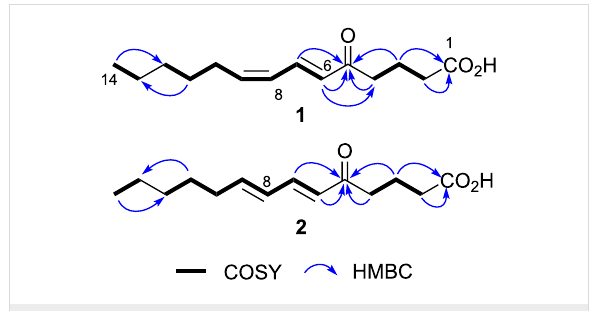
Figure 2: COSY and key HMBC correlations for 1 and 2 .